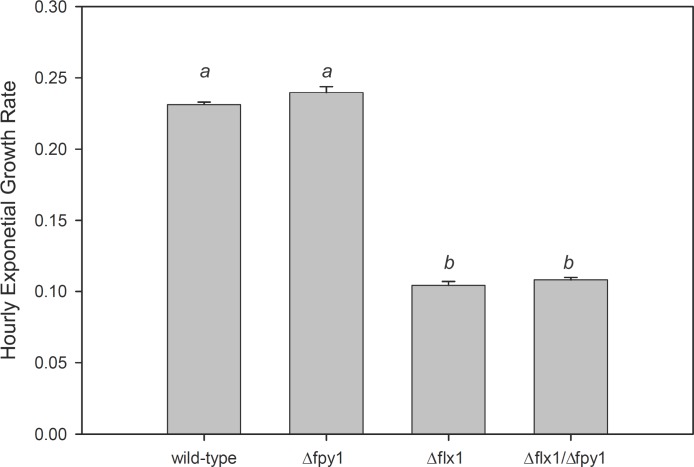
Comparison of exponential growth rates of yeast grown on YP + 1% sodium acetate.The portion of the growth curves which appeared linear on a semi-log plot (6–20 hours for wild type and Δfpy1, 36–52 hours for Δflx1 and Δflx1/Δfpy1) were fit by least squares regression to the equation for exponential growth. Data for each condition are given as the average ± SE of three individual cultures. Different letters signify data which are statistically different (p < .05) based on one-way ANOVA with Holm-Šidák pairwise comparison.